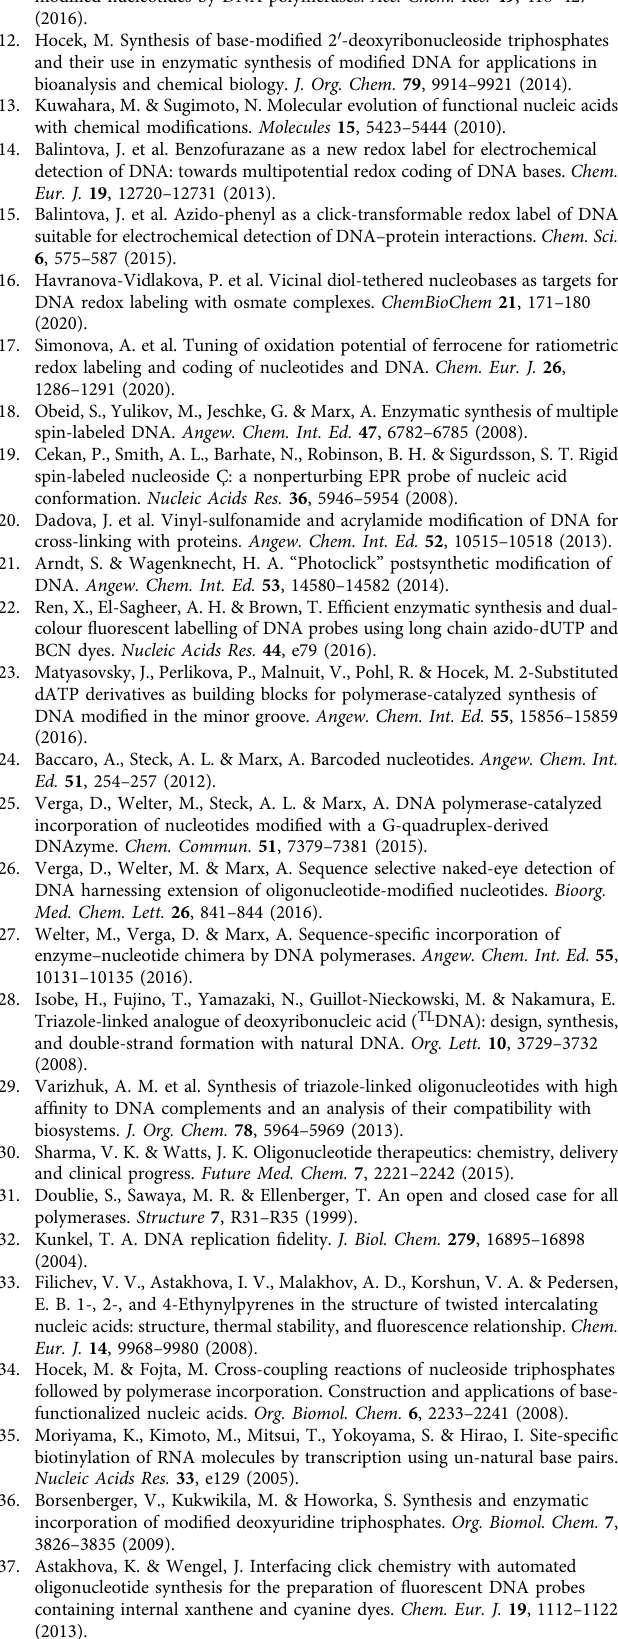
Table 3 Polymerases tested for dd ON NTP